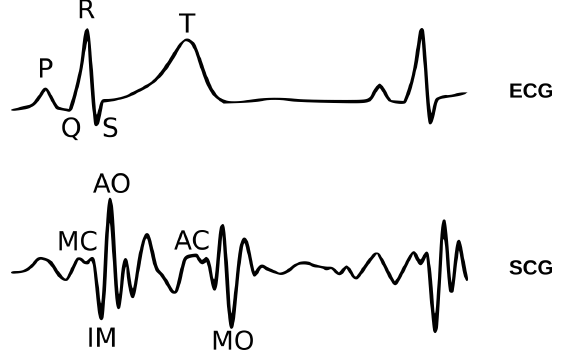
Figure 1. Temporal relations between ECG and SCG waveforms; fiducial points of each signal are annotated as